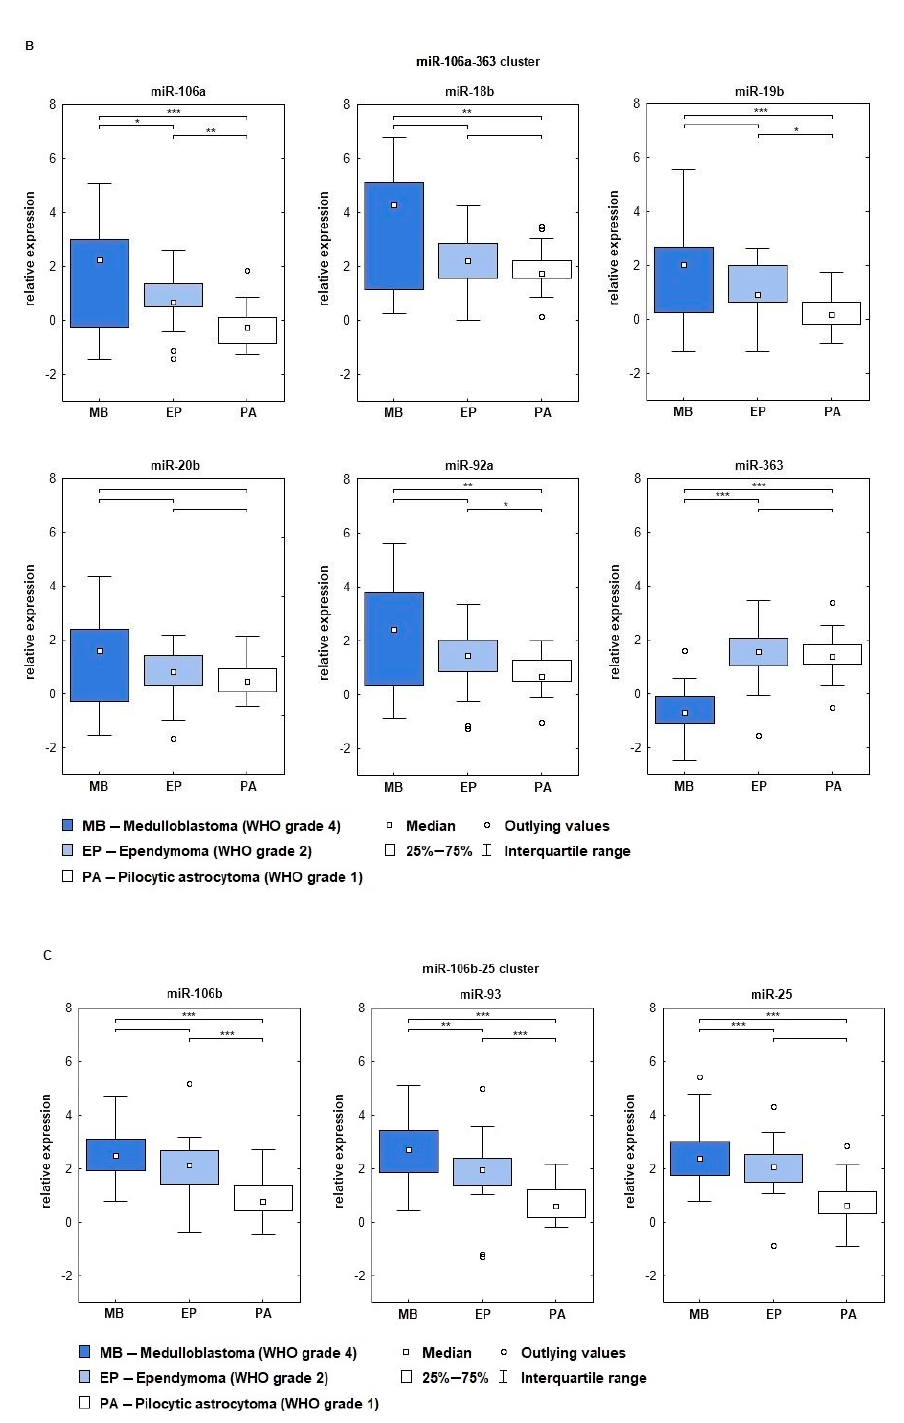
Figure 3. Relative expression of miRNAs from miR-17-92, miR-106a-363, and miR-106b-25 clusters in the analyzed groups of pediatric brain tumors. Relative expression is given in ddCt values. ( A ) miR-17-92 cluster; ( B ) miR-106a-363 cluster; ( C ) miR-106b-25 cluster; * p < 0.05, ** p < 0.01, *** p < 0.001.